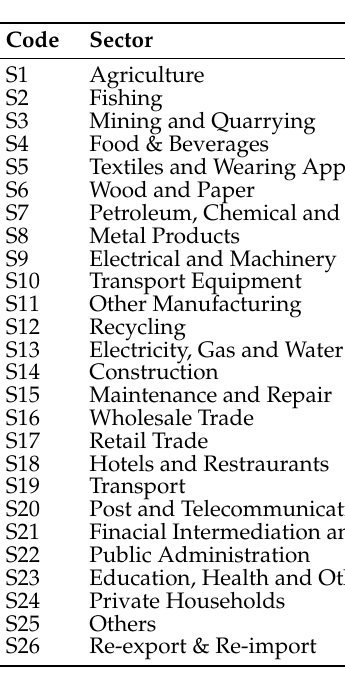
Table A1. Codes and sectors.